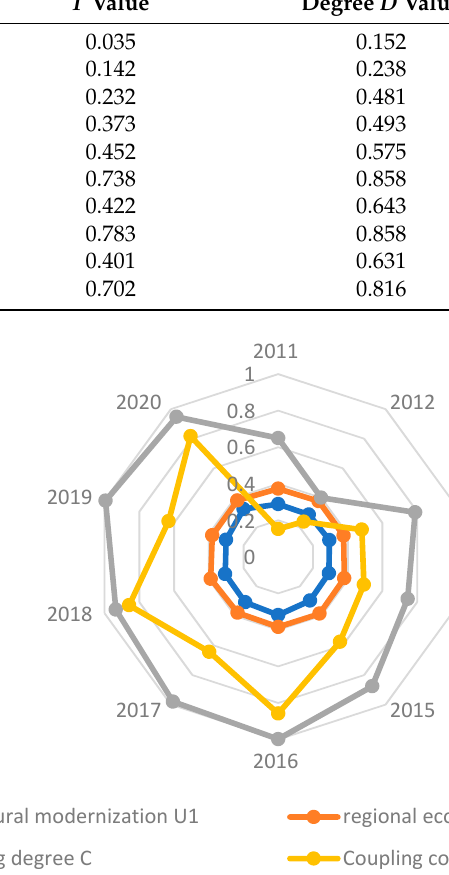
Figure 3. Time-series coupling analysis of China’s agricultural modernization and regional economic development level.